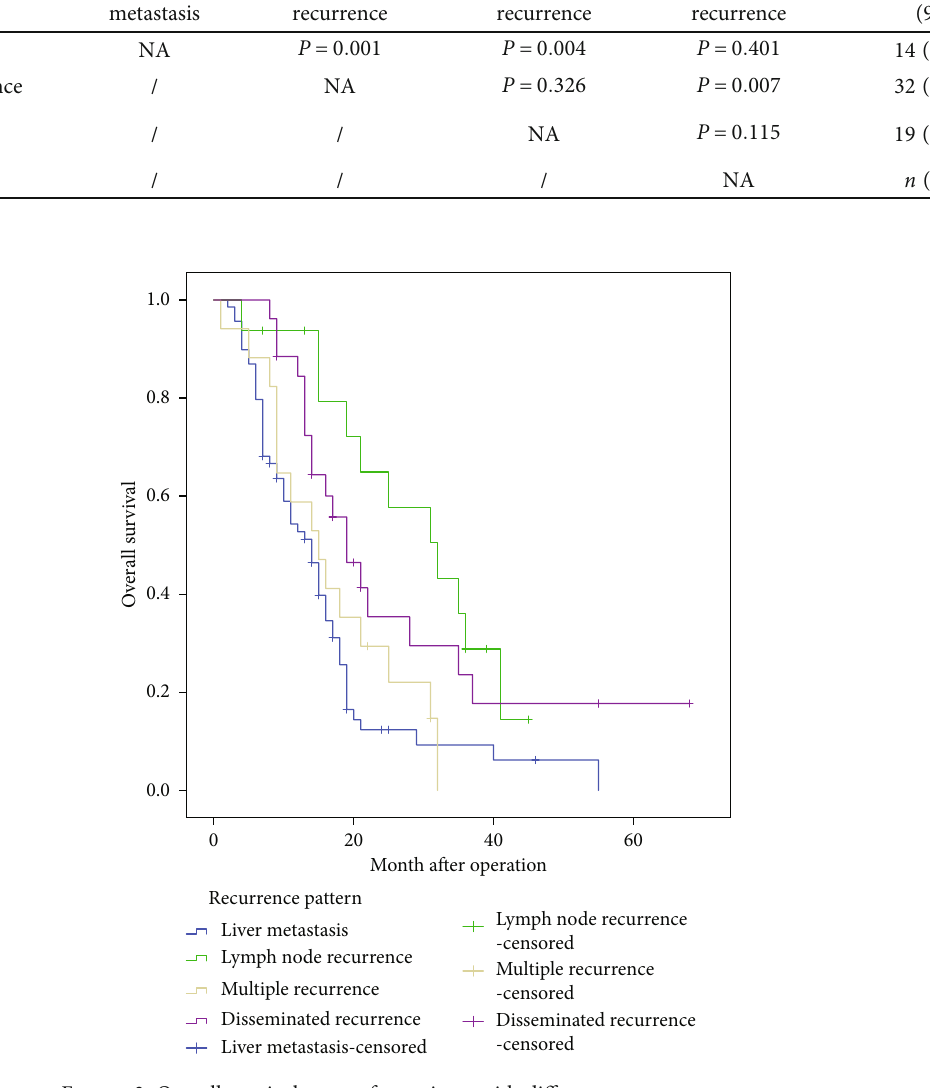
Figure 3: Overall survival curves for patients with di ff erent recurrence